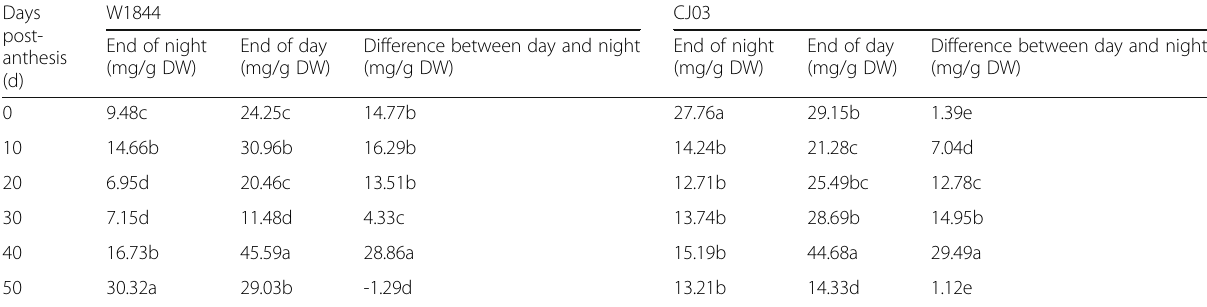
Different letters indicate statistically significant differences at the P =0.05 level